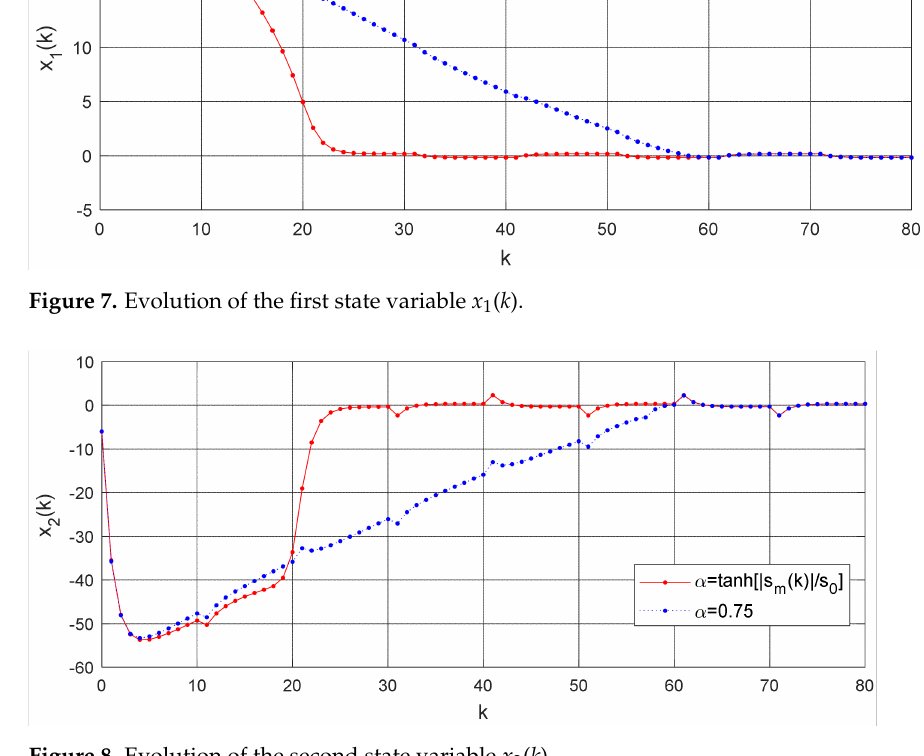
Figure 8. Evolution of the second state variable x 2 ( k